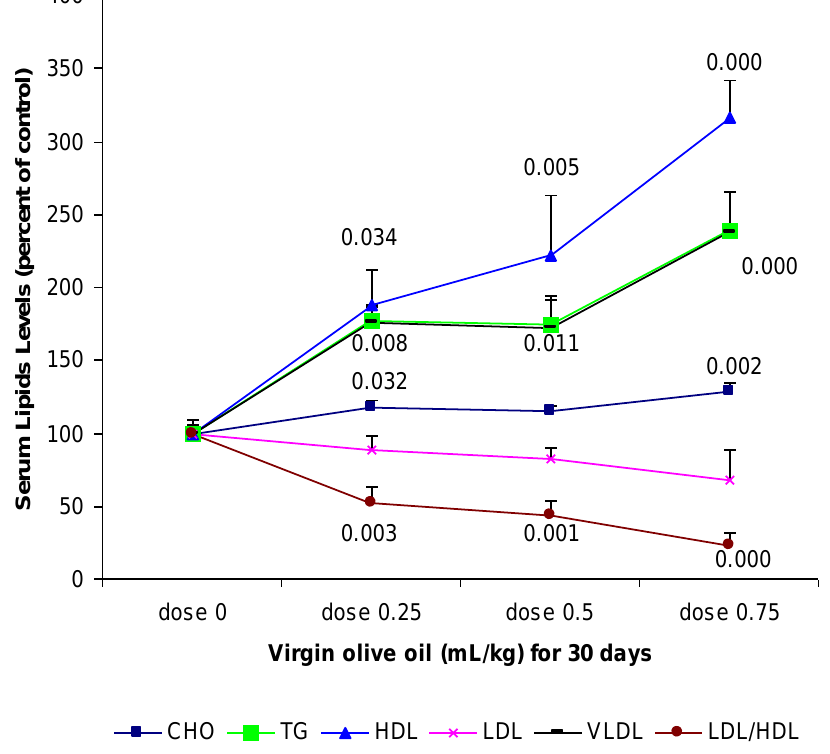
FIGURE 2. Serum lipid levels at the end of VOO pretreatment. VOO increased cholesterol levels by pretreatment with dose 0.25 and 0.75 mL/kg/day, and triglyceride, HDL, and VLDL levels at